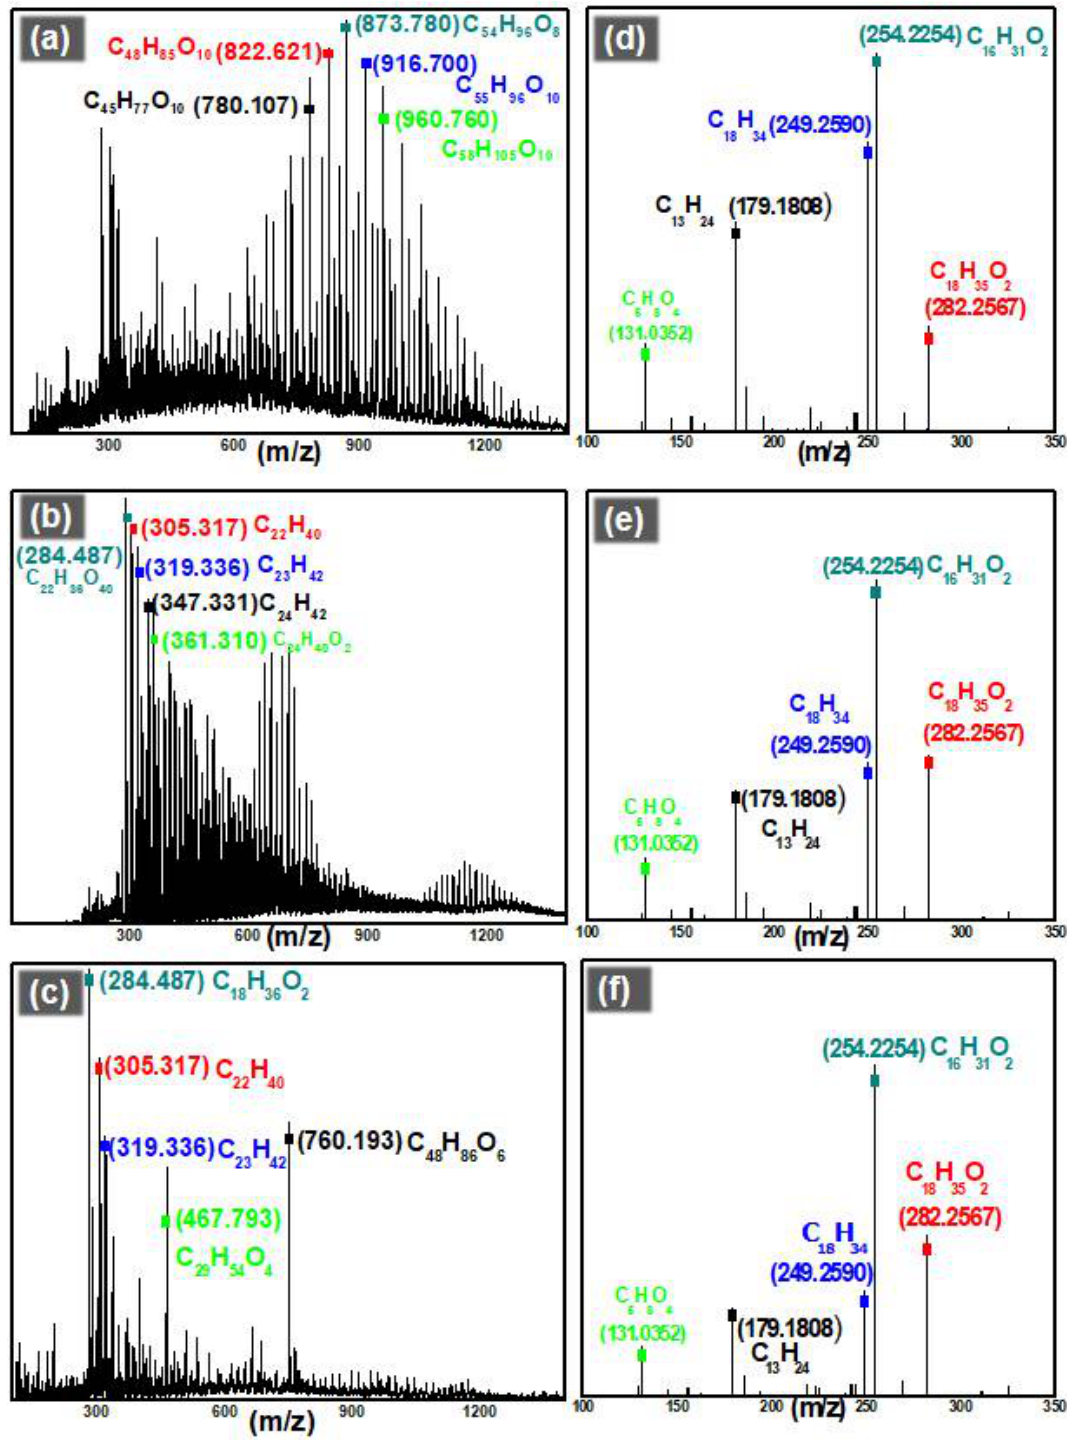
Figure 4. ESI-MS analysis of the wax produced by degradation of PE ( a ) without catalyst, ( b ) catalyzed by γ-Al 2 O 3 and ( c ) catalyzed by Ga-doped γ-Al 2 O 3 . ESI-MS analysis of the oil precursors produced by degradation of 1-octadecene ( d ) without catalyst, ( e ) catalyzed by γ-Al 2 O 3 and ( f ) catalyzed by Ga-doped γ-Al 2 O 3 .